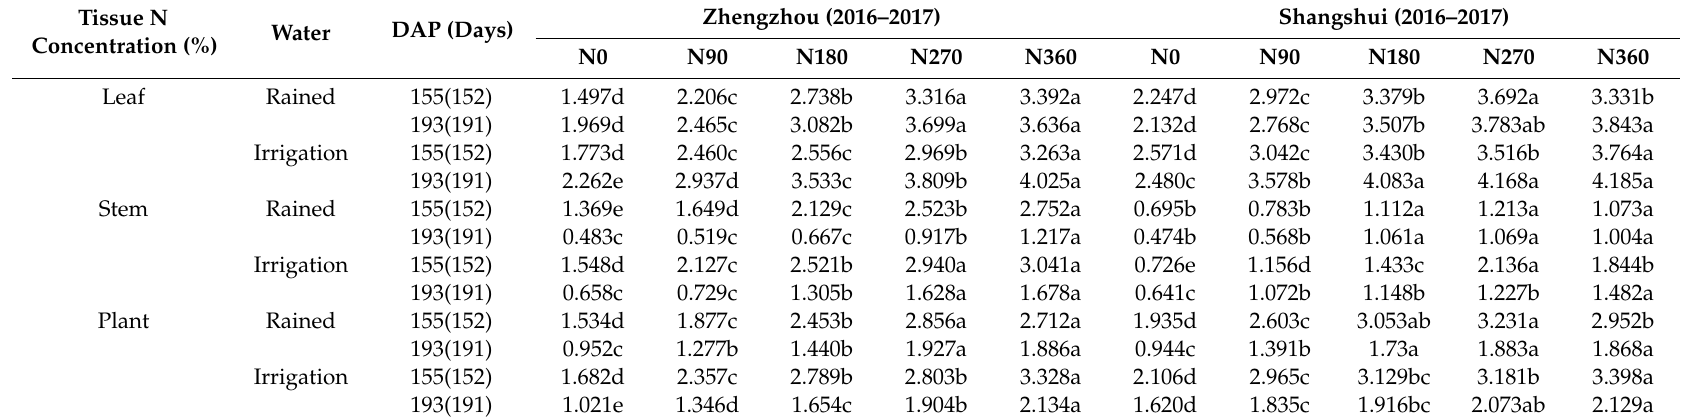
Table 5. E ff ects of N rate and water on tissue N concentration under di ff erent years and sites in Exp. 2 and